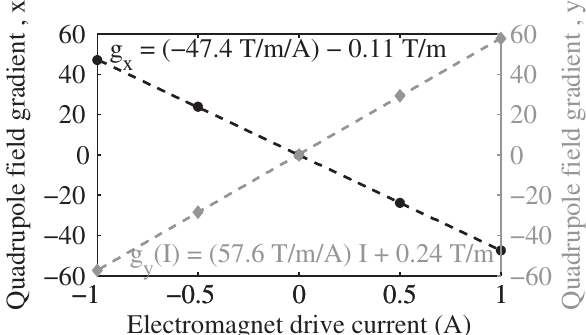
FIG. 13. Transverse field gradient measured with a 0.02 mm electron beam probe. Gradient measured along the horizontal axis is black and measured along the vertical axis is